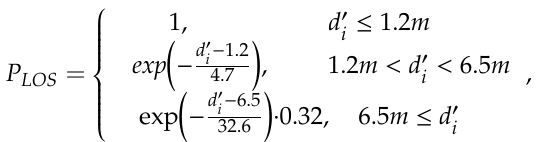
Figure 10. The CDF of positioning error with different BS selection methods.